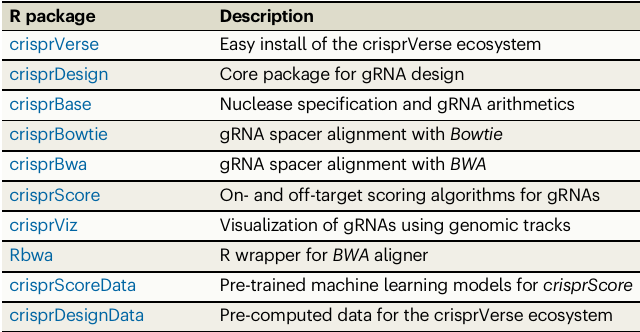
Table 2 | R packages in the crisprVerse